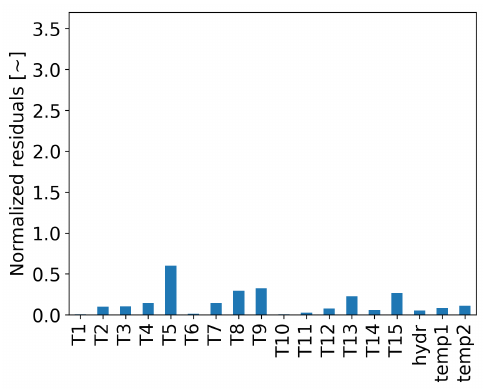
Figure 21. Autoencoder: bar plots of MAE residuals (November